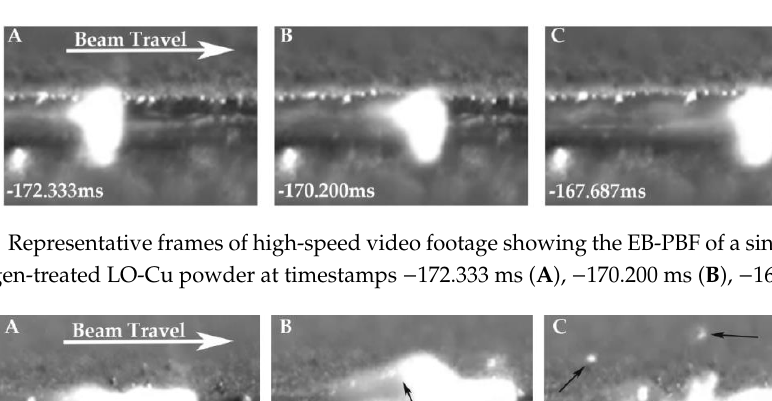
Figure 14. Residual gas analysis of HO-Cu, MO-Cu, and LO-Cu powder during the electron beam powder bed fusion (EB-PBF) of single layer discs.